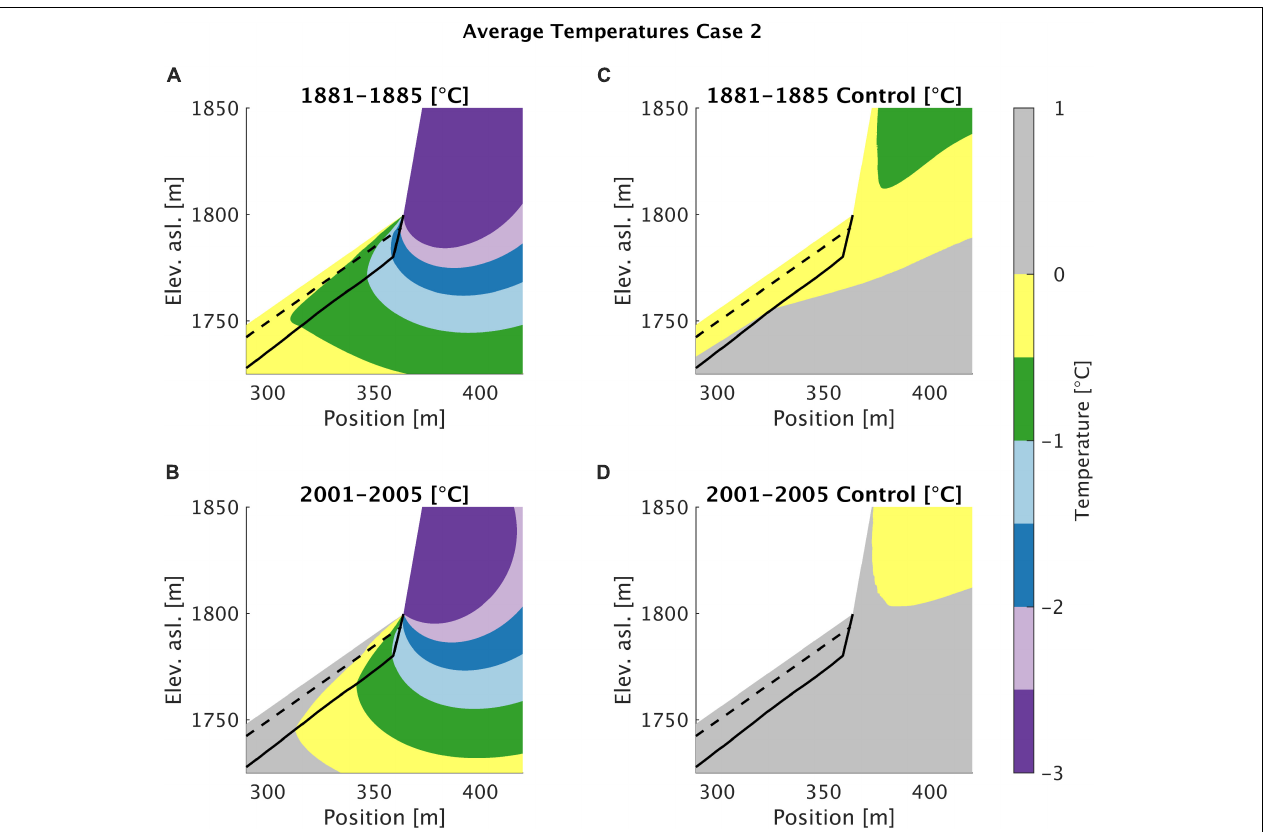
FIGURE 2 | Comparison of the modeled temporal evolution of the thermal regime for Case 2 (A,B) and Case 2 Control (C,D) simulations. The comparison is made between average temperatures over two 5-year periods 1881–1885 and 2001–2005. The plotted areas are cut-outs from the numerical domain presented in Figure 1B . Colors indicate temperatures below 0 ◦ C. Simulations are run with elevation 1700–1900 m asl., with thermal conductivity k = 3.5 W/m ◦ C and geothermal heat flux 50 mW/m 2 . Snow covers are implemented along the talus slope for both simulations by means of nF = 0.2. For the control simulation (C,D) , nF = 0.2 is implemented along the steep rock